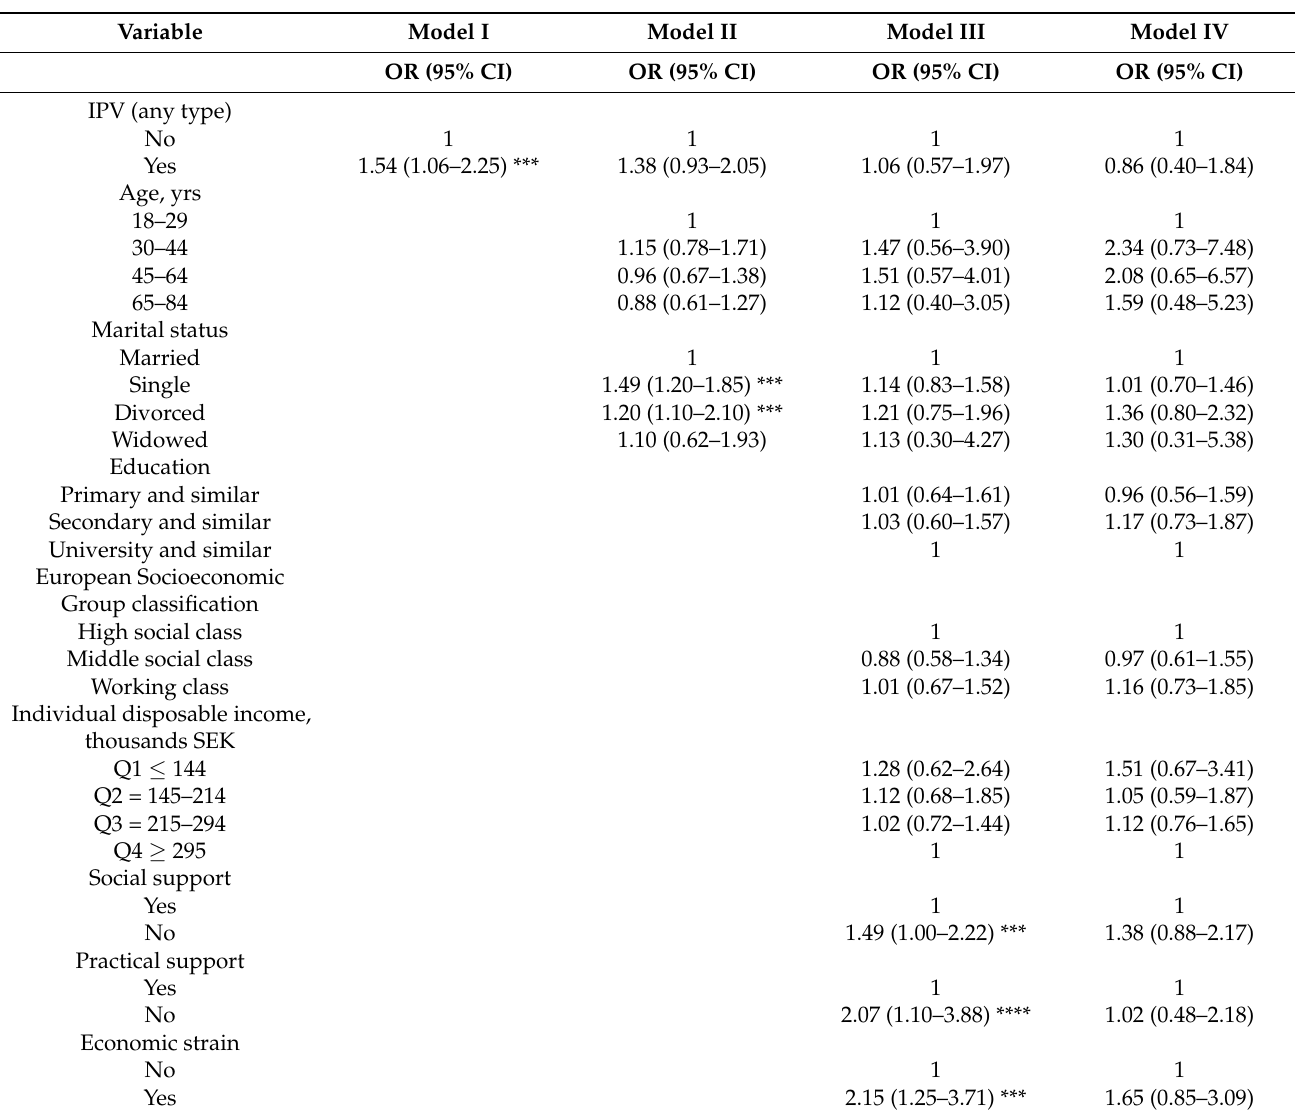
Table 3. Odds ratios (ORs) with 95% confidence intervals (CIs) for the relationship between interper- sonal violence (IPV) and anxiety among men, according to the Gävlebörg Health on Equal Terms Survey